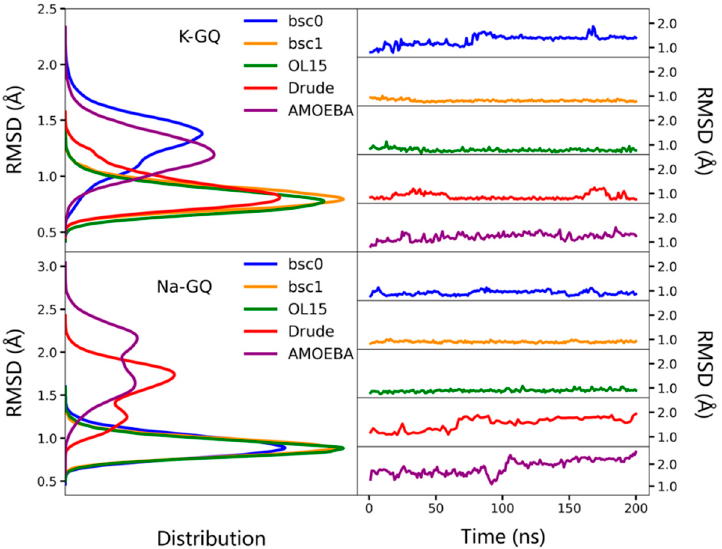
Figure 2. The RMSDs of backbone atoms (C3 ′ , C4 ′ , C5 ′ , O3 ′ , O5 ′ , P) in K ‐ GQ and Na ‐ GQ during MD simulation with different force fields. The experimental structures were used as references. To show the results more clearly, the average RMSD value of every 100 snapshots is shown .